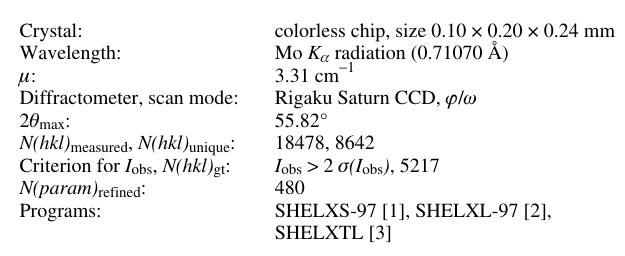
Table 1. Data collection and handling.